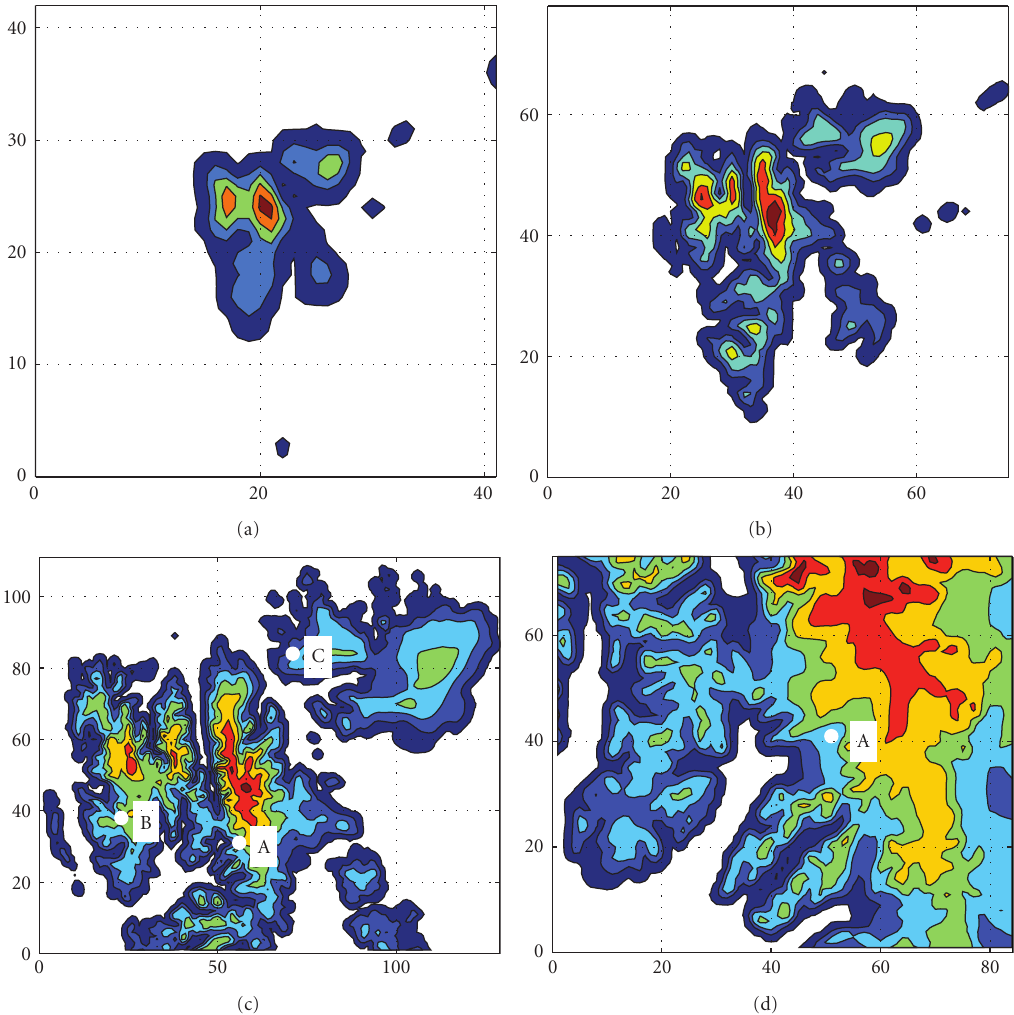
Figure 1: Model domains of the nests with 24 km (a), 8 km (b), 2.7km (c), and 900m (d) resolution, respectively. Contour lines show terrain with 200m equidistance (terrain exceeding 1200 m in (c) and (d)) and numbers represent grid points. The AWS sites are marked out in (c) as (A) Nordenski¨oldbreen, (B) Kongsvegen, and (C)